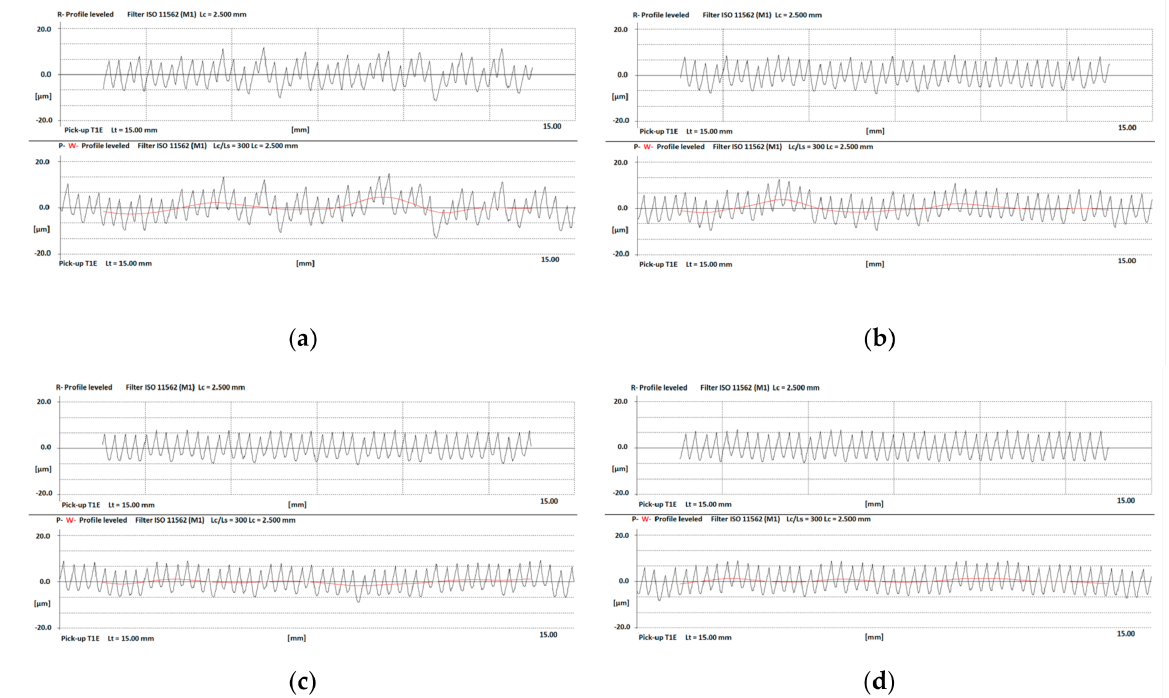
Figure 3. R (roughness), W (waviness), and P (primary) profiles of the first machined sample (L/D = 12; AISI 304):